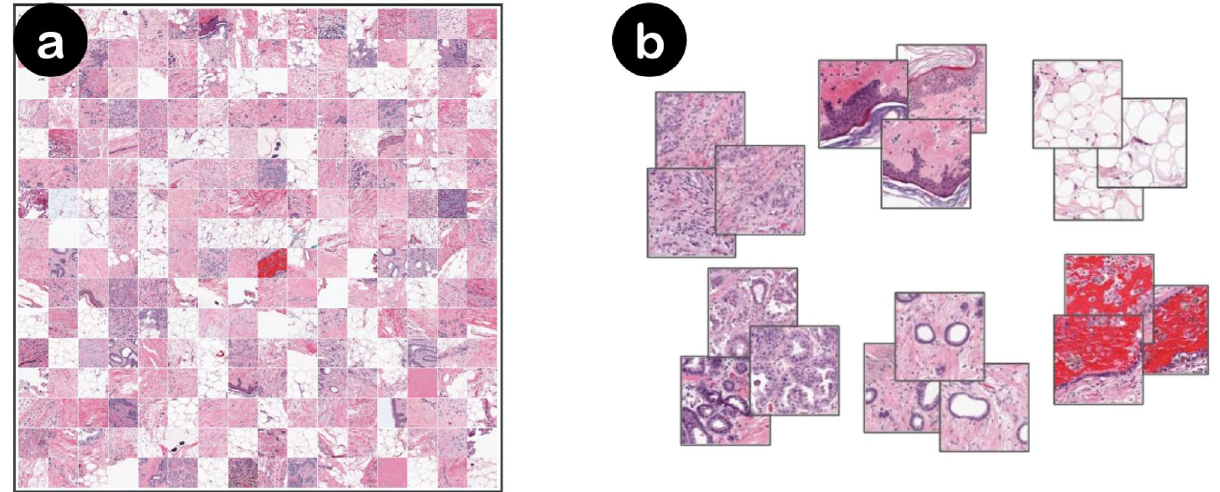
Figure 1. Negative mining with random sampling versus feature based K-means clustering from whole-slide images. Both figures are extracted from actual experiments. ( a ) Random sampling ( b ) K-means sampling. In ( b ), we show the three samples closest to the centres of six randomly selected clusters for illustration.